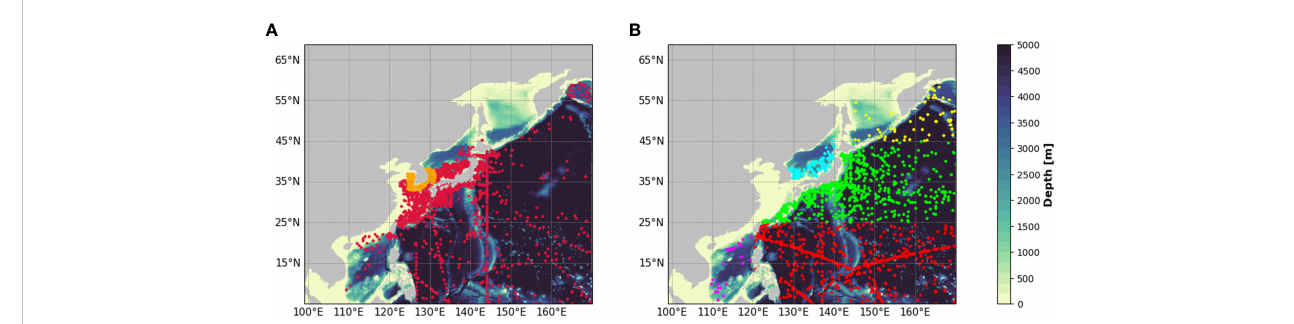
FIGURE 2 Distribution of in-situ temperature pro fi les used in data assimilation and validation. (A) temperature pro fi les used in data assimilation in February 1993. Crimson and orange dots denote pro fi les taken from World Ocean Database 2018 and Korea Oceanographic Data Center (KODC), respectively. (B) temperature pro fi les used in validation. Red, magenta, yellow, cyan and green dots denote temperature pro fi les located Northwestern Paci fi c (NWP), South China Sea (SCS), Oyashio Current (OYC), East/Japan Sea (EJS) and Kuroshio-Kuroshio Extension (K-KE) region,